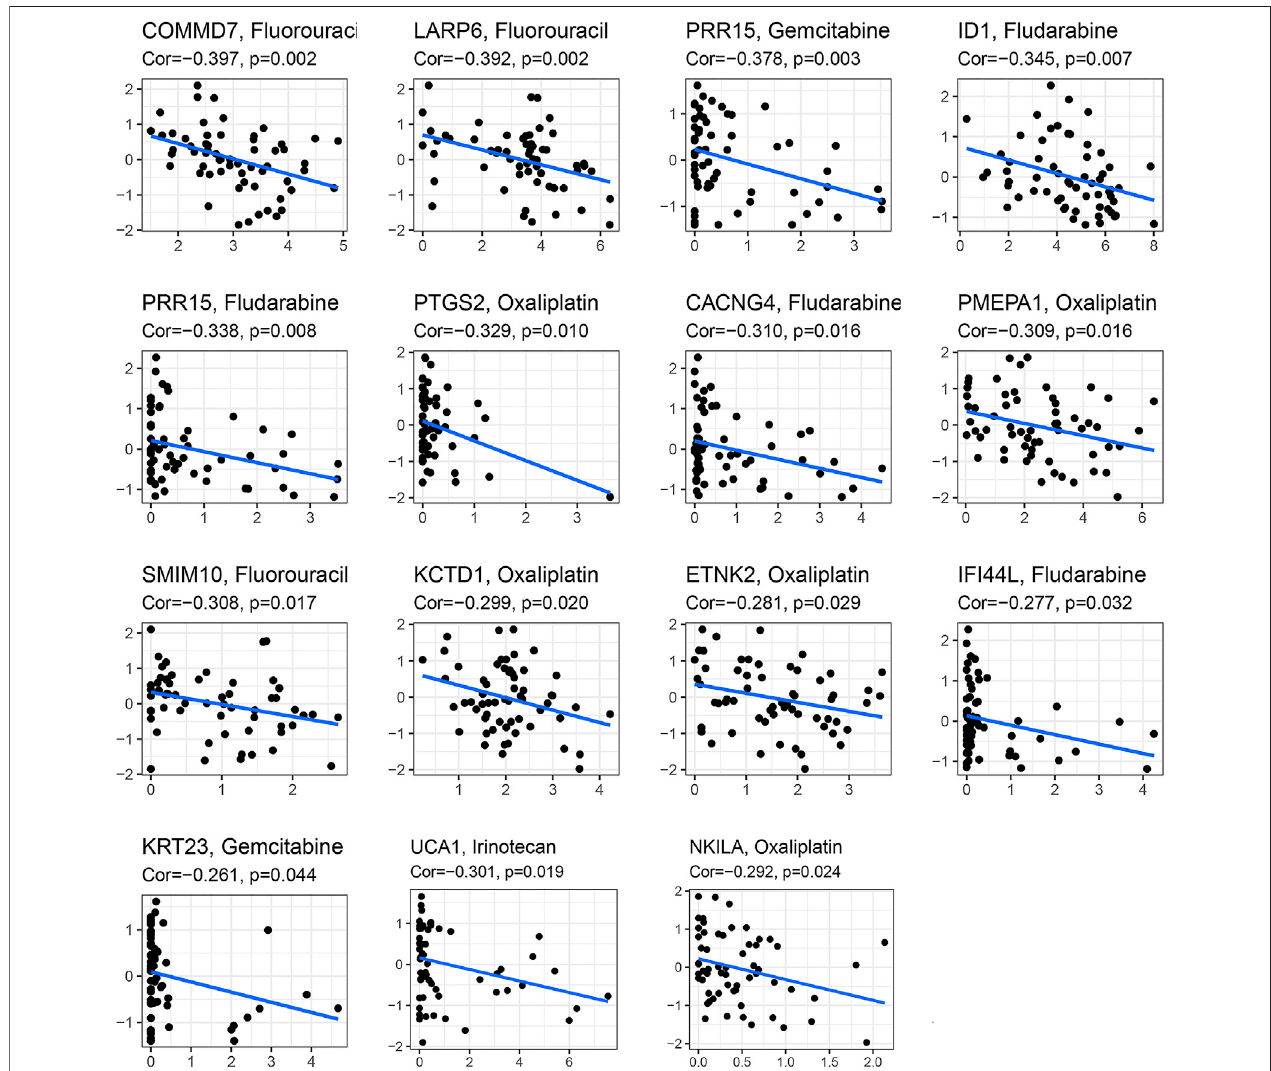
FIGURE 8 | The correlation analysis in the expression of DGIA lncRNAs and co-expressed mRNA with a sensitivity of chemotherapy drugs.